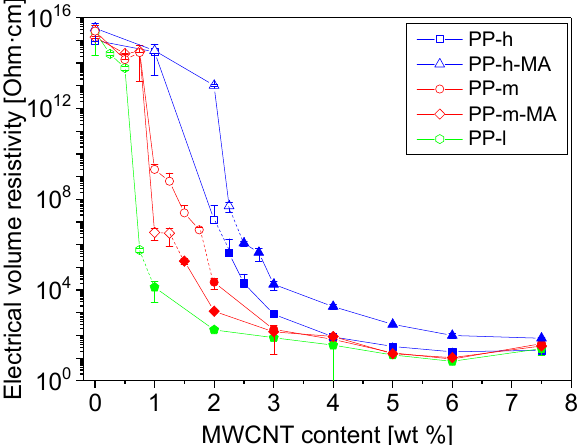
Figure 3. Electrical volume resistivity of the composites prepared by direct incorporation (5 min) of MWCNTs.